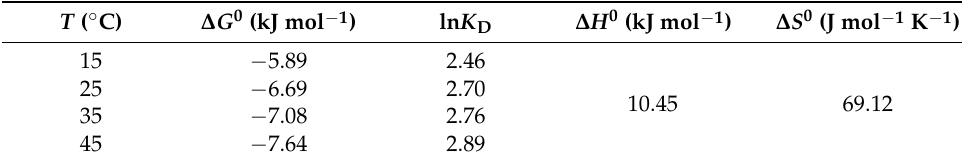
Figure 11. Reusability of LMF11 NFs ( a ) and photo of magnetic separation ( b ).